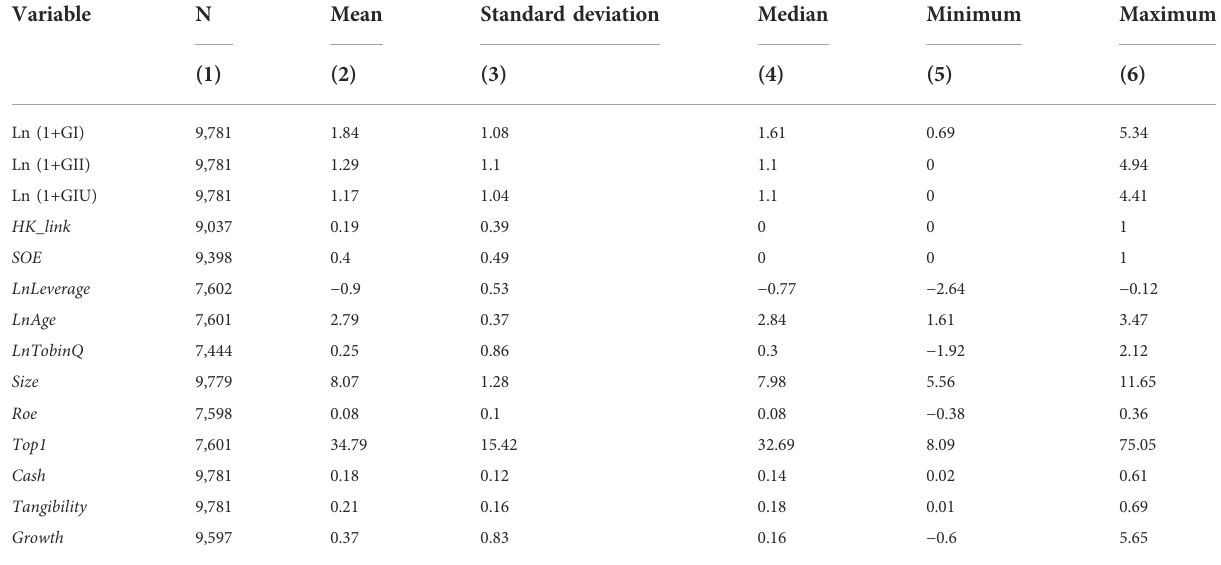
TABLE 2 Descriptive